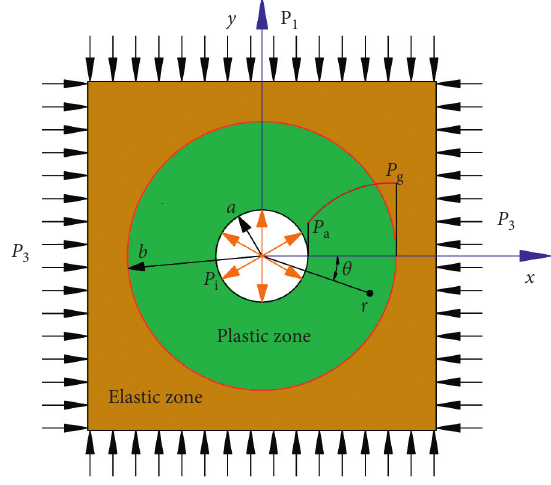
Figure 1: Mechanical model of roadway.